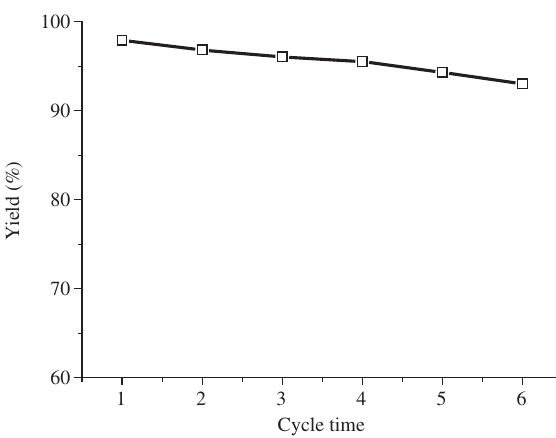
H PW O catalyst during esteri- 1.0 2.0 12 40